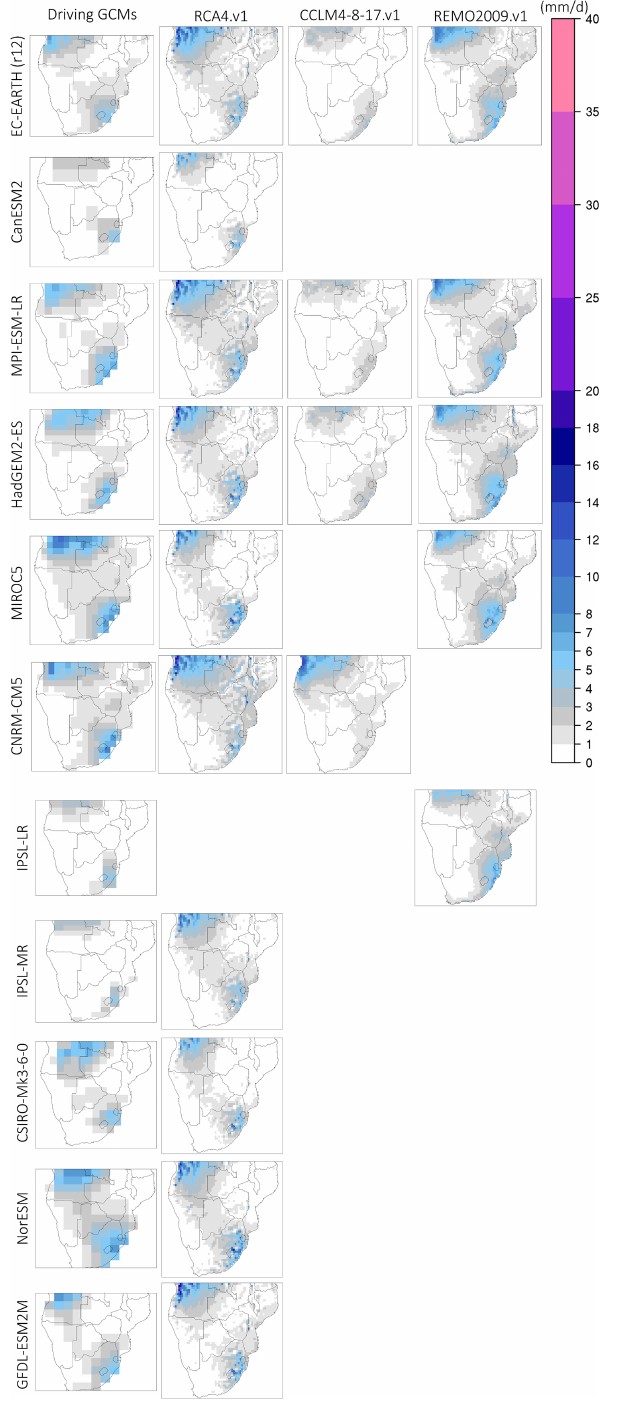
Figure 4. Monthly precipitation climatologies (mmd − 1 ) during January for the period 1985–2005. The first column (from the left) displays precipitation from the driving GCMs, and columns 2–4 dis- play the downscaled precipitation output from RCA4.v1, CCLM4- 8-17.v1, and